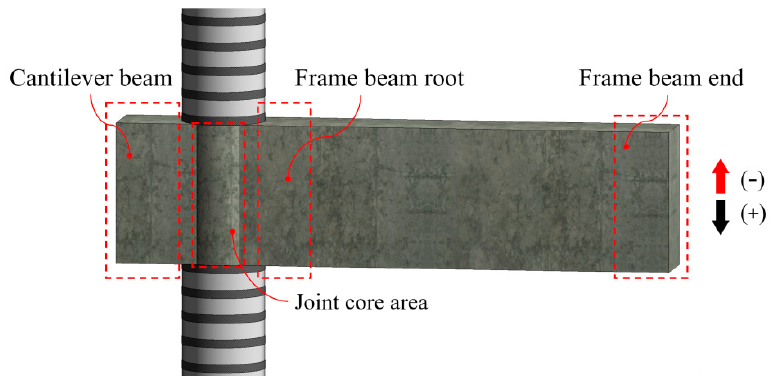
Figure 4. Denomination of the components.